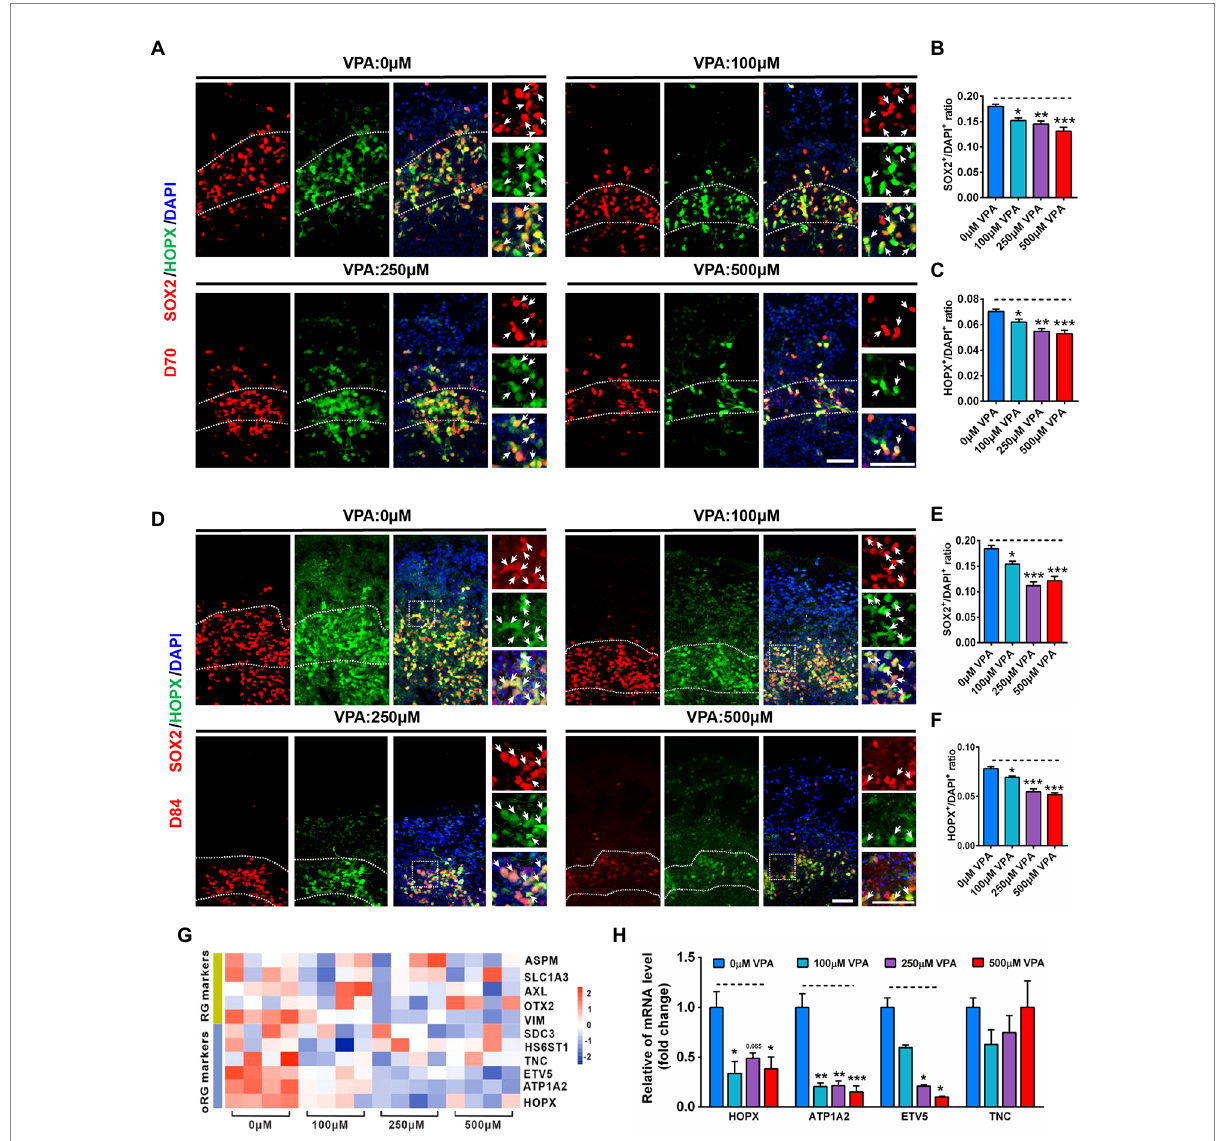
FIGURE 7 VPA exposure decreased oRG-like cell production in human dorsal forebrain organoids. (A) Representative image of 0, 100, 250, and 500 μ M VPA treated human dorsal forebrain organoids for SOX2 (red) and HOPX (green) at day 70. Scale bars, 50 μ m. (B,C) Quantification of the ratios of SOX2 + /DAPI + and HOPX + /DAPI + in the oSVZ-like regions of organoids at day 70 ( n = 4 organoids each). (D) Representative images of 0, 100, 250, and 500 μ M VPA treated human dorsal forebrain organoids for SOX2 and HOPX at day 84. Scale bar, 50 μ m. (E,F) Quantification of the ratios of SOX2 + /DAPI + (E) and HOPX + /DAPI + (F) in the oSVZ-like regions of organoids at day 84 ( n = 4 organoids each). (G) Heatmap displaying relative gene expression of marker genes (RG identity markers, oRG markers) of 0, 100, 250, and 500 μ M VPA treated human dorsal forebrain organoids ( n = 4 organoids each). (H) RT-qPCR were conducted to confirm the results of RNA-seq of (G) ( n = 3 organoids each). * p > 0.05, ** p > 0.01, *** p >